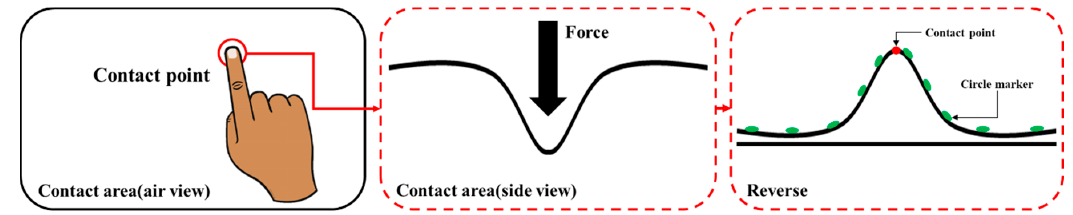
Figure 12. Basis for application of Gaussian fitting algorithm.